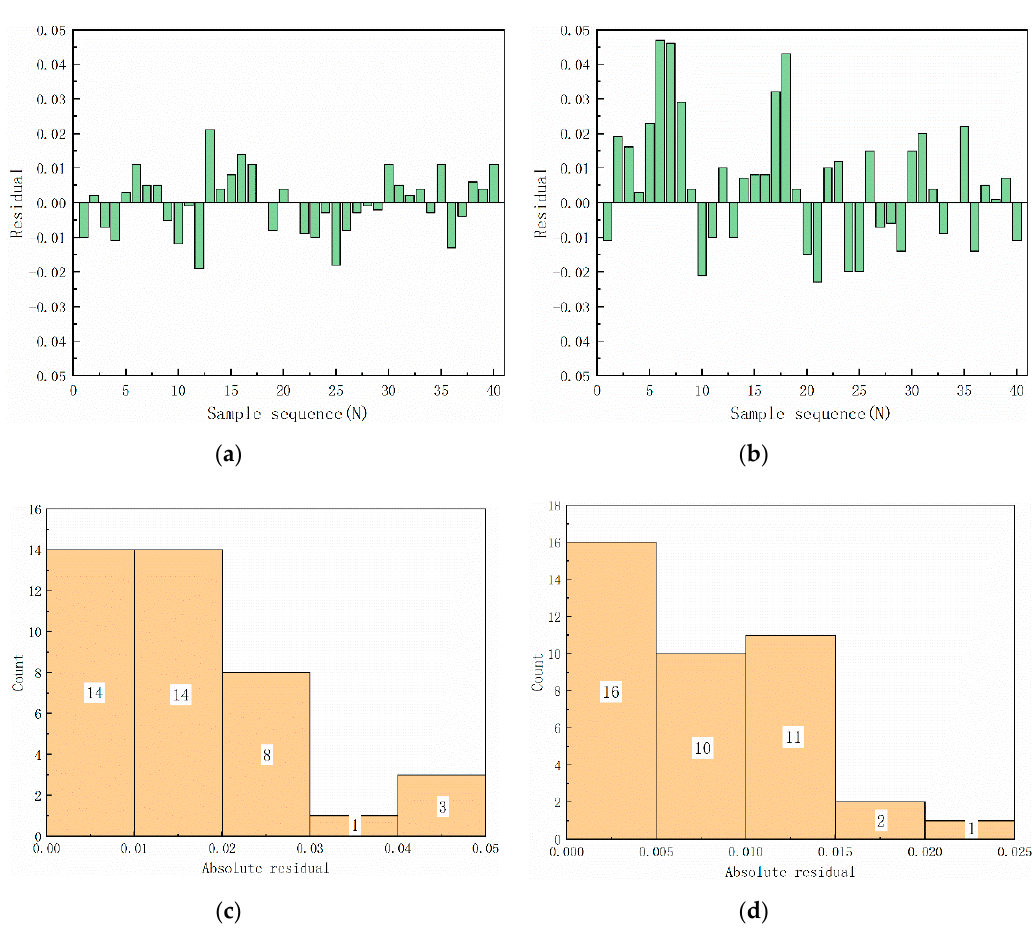
Figure 9. Residual of ( a ) LSTM, and ( b ) BP methods on the testing set; distribution diagram of the absolute residual values of ( c ) LSTM, and ( d ) BP methods.